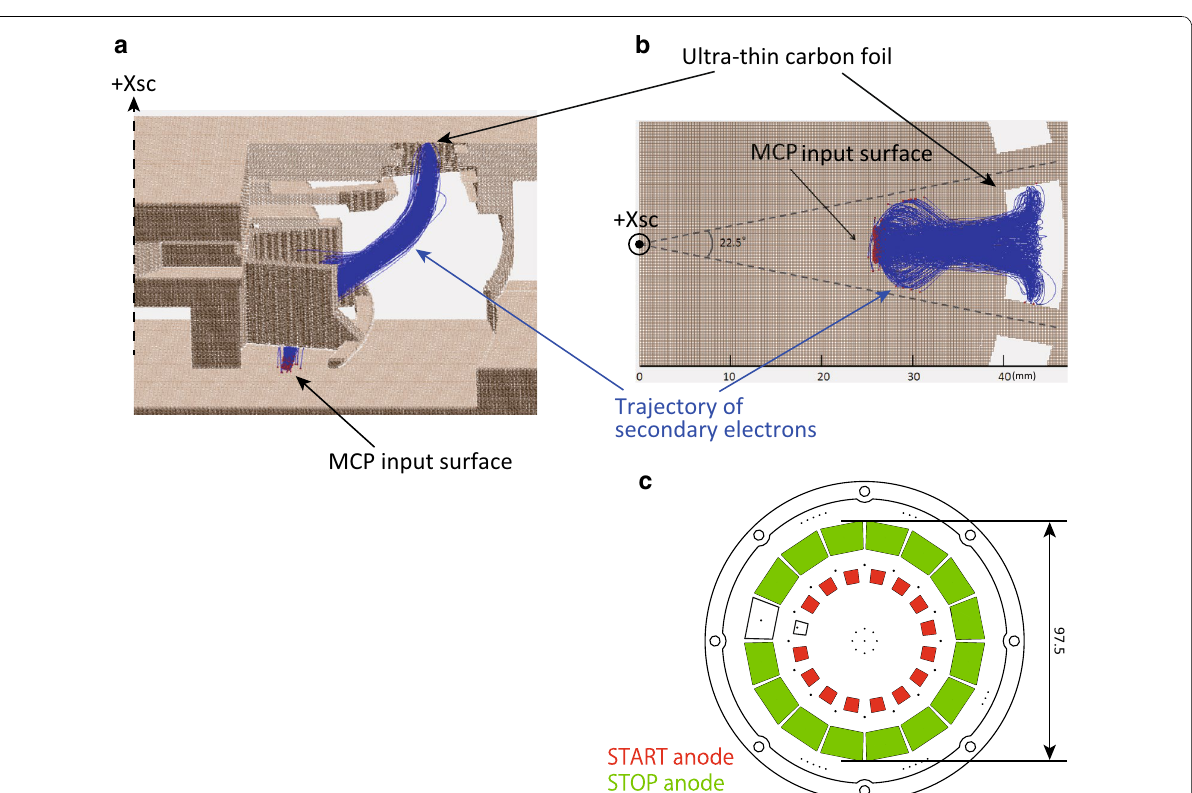
Fig. 10 Shape of the MCP anode and sample trajectories of secondary electrons emitted from the ultra-thin carbon foil. a Cut-away view of the TOF section. Brown area indicates electrodes. Sample trajectories of the secondary electrons are drawn in blue lines. Red points indicate the reach points of the particles. b Same as a but horizontal view of the TOF section. Foil area is indicated in white. c Shape of the MCP anode. Red and green areas indicate START and STOP anodes,